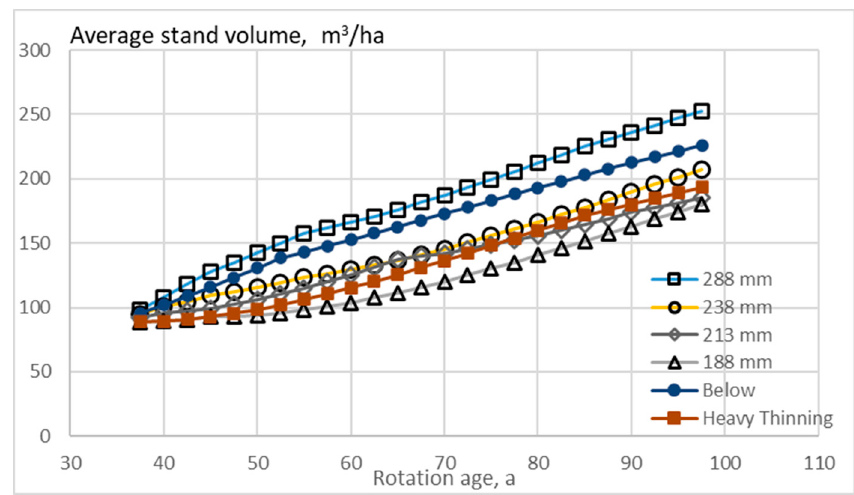
Figure 5. The expected value of commercial stand volume for six different treatment schedules applied on a normal stand representing the example estate. The volume is integrated over stand age until any rotation age.